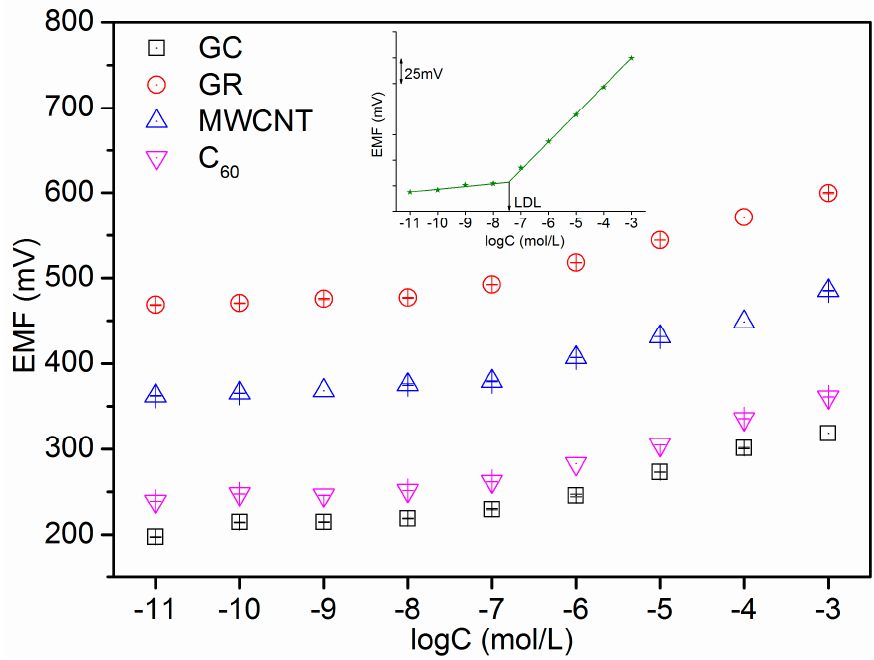
Figure 5. Potentiometric calibration curve of different Pb 2+ ‐ ISEs in lead concentration range from 10 − 11 to 10 − 3 M. Table 1. Comparison of different Pb 2+ ‐ ISEs characteristics.